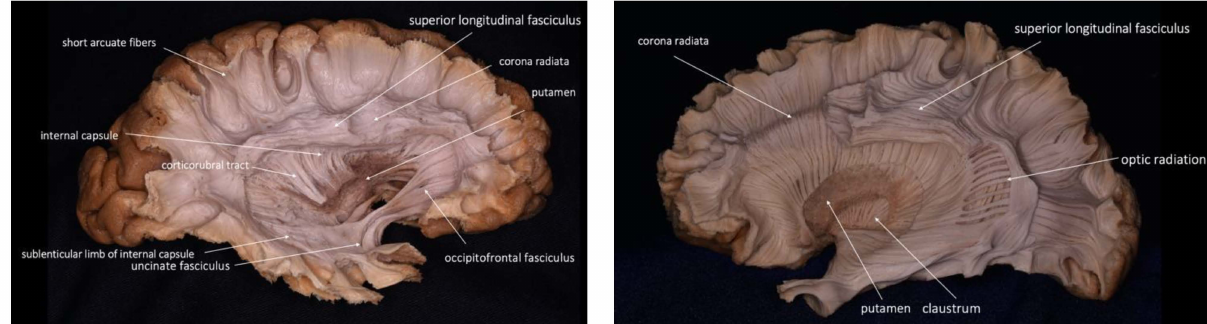
Figure 6. Cadaveric white matter dissection showing the fiber tracts commonly taken into account during the planning stage and intraoperatively for a safe tumor resection.